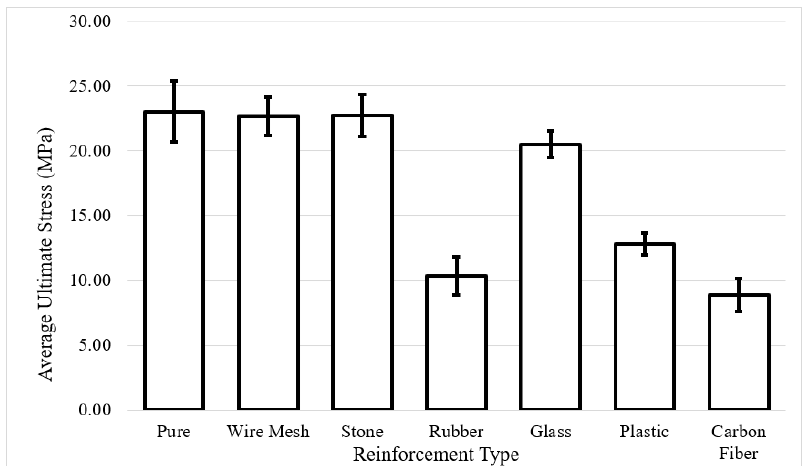
Figure 5. Average Ultimate Stress for Each Reinforcement Type .